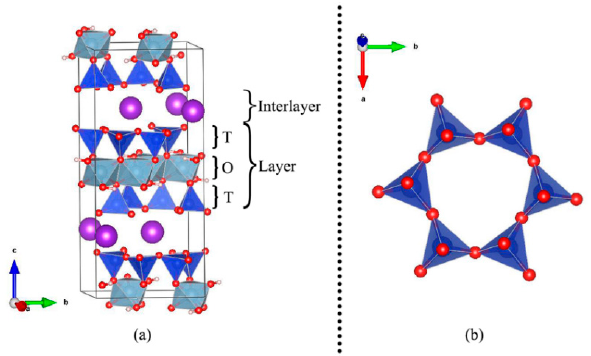
Figure 1. The structure of ( a ) unit cell and ( b ) quasi-hexagonal ring of SiO 4 units.